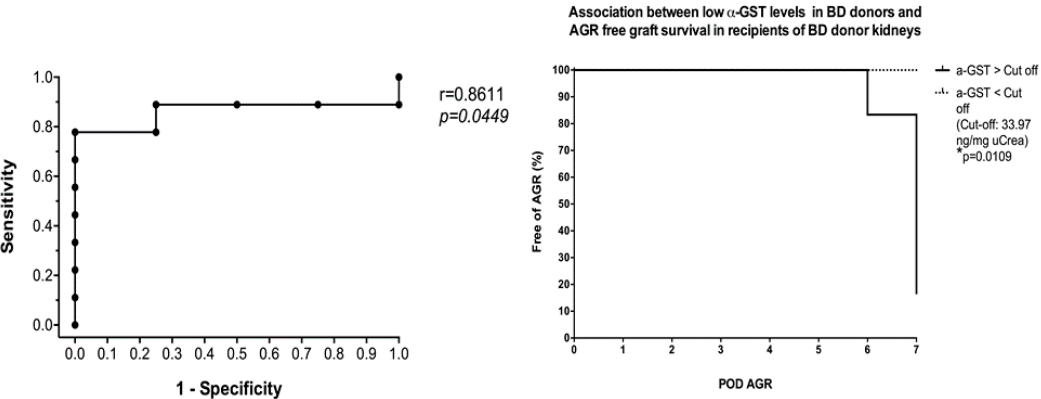
Figure 6. Urinary α - and π -GST levels in deceased donors before transplantation; G1: Acute graft rejection (AGR), G2: Calcineurin-induced nephrotoxicity (CNI), G3: Simultaneous acute graft rejection and calcineurin-induced nephrotoxicity (AGR+CNI), G4: Delayed graft function (DGF), G5: Event-free (control).